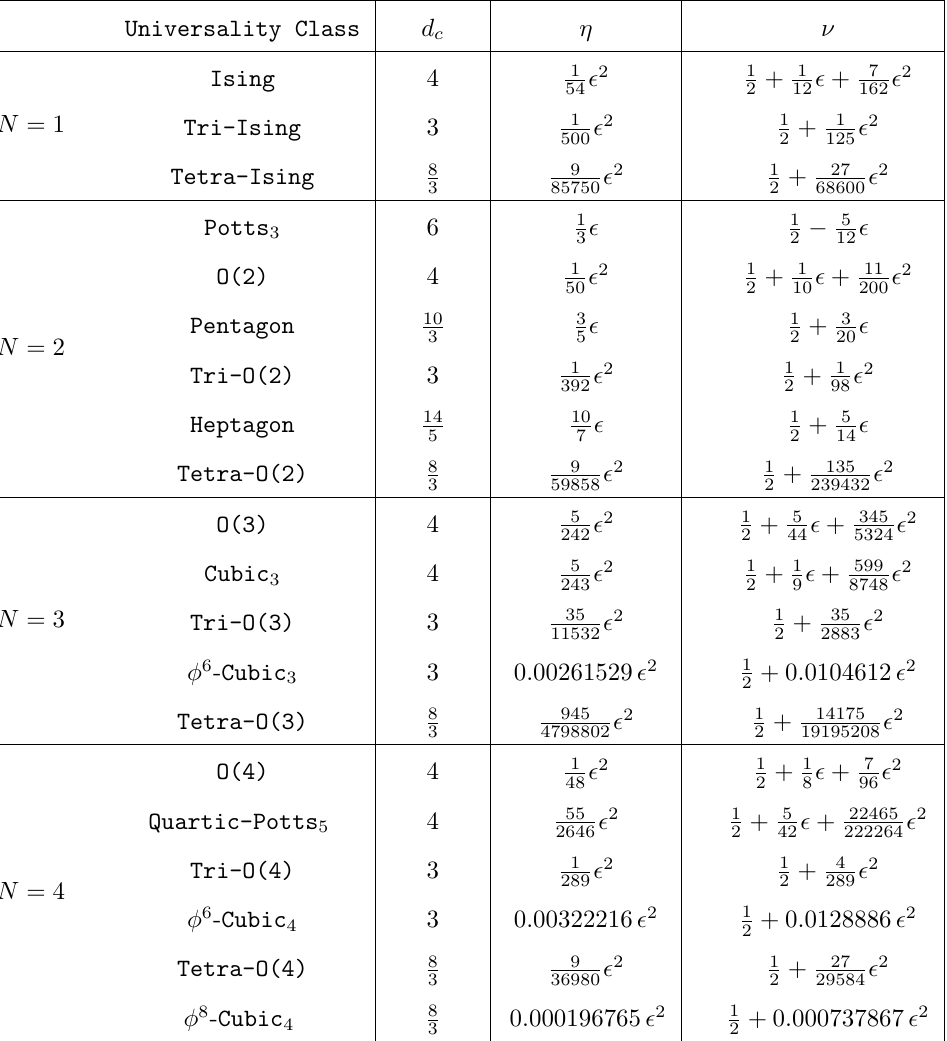
Table 4 . Critical exponents (cid:17) and (cid:23) for the universality classes with d c = 6 ; 4 ; 10 = 3 ; 3 ; 14 = 5 ; 8 = 3 (for which we know both of them) ordered by the number of (cid:12)eld